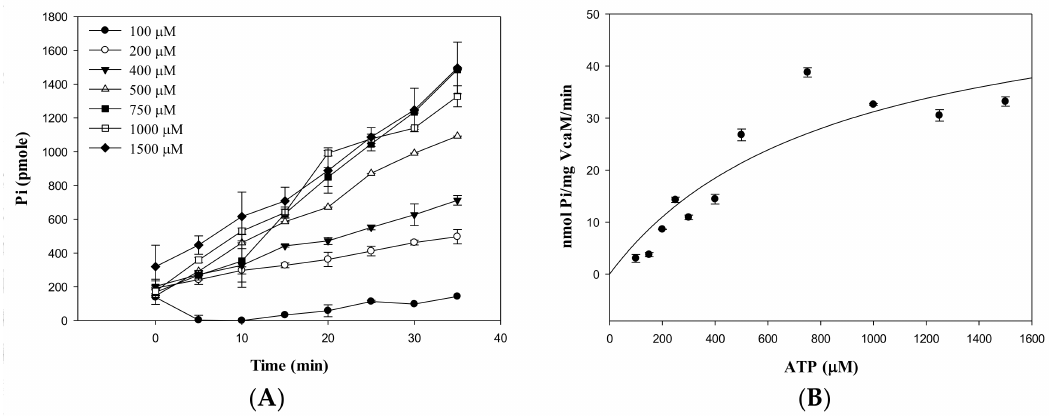
Figure 2. The Adenosine triphosphatase (ATPase) activity of VcaM. ( A ) Pi generation by VcaM on various concentration of ATP (B) The steady-state rate of Pi production by VcaM. The ATPase activity was measured by malachite green assay using 0.5 mM VcaM in detergent-solubilised state. This level of activity is comparable to the previously reported ATPase activity of purified MacB, which has a K m value of 910 µ M and a K cat of 0.17 s − 1 [32]. It was previously reported that Sav1866 from Staphylococcus aureus exhibited a V max of 63 nmol Pi/mg − 1 min − 1 although the K m value for ATP 44.4 ± 0.5 nmol min − 1 mg protein − 1